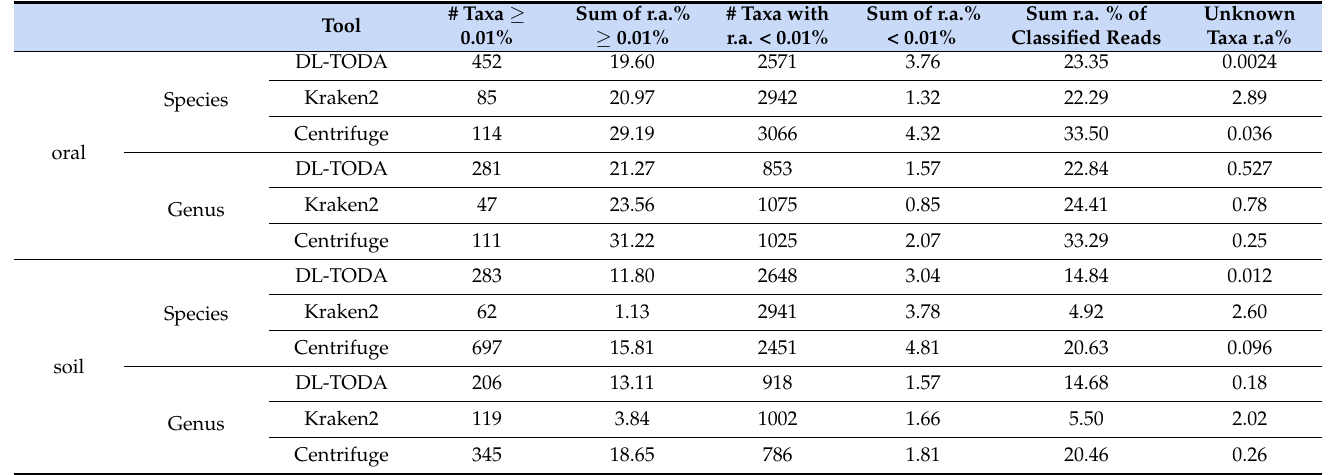
Table 4. Summary of species and genus level classifications made by DL-TODA, Centrifuge and Kraken2 on the human oral and soil metagenomes. The number (#) of taxa observed with relative abundances (r.a.%) ≥ 0.01% or <0.01% is reported in the table. Relative abundances represent the percentage of classified reads over the total number of reads in the metagenomes. Unknown taxa represent groups at a given taxonomic level that are not named in the NCBI